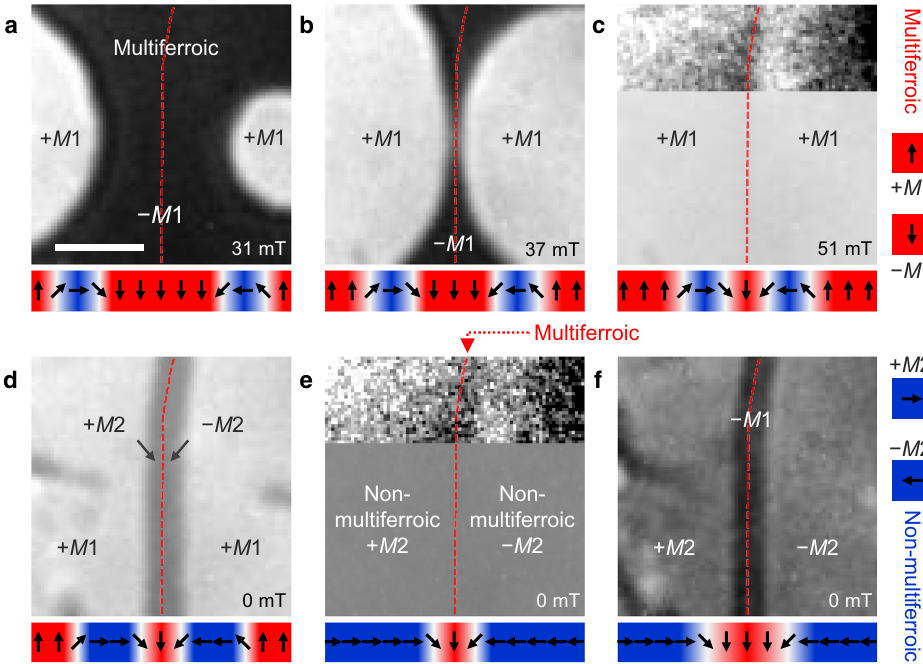
Fig. 2 Transformation of a multiferroic bulk domain into a multiferroic domain wall in a non-multiferroic environment. Panels a – f show the same area, using the same gray scale (except in the insets of c and e , which are rescaled to minimum = black, maximum = white). Arrows indicate the order- parameter orientation (see Fig. 1a) for the horizontal succession of phases in the associated images. a – c Starting from a single-domain state ( − M 1, dark), two opposite multiferroic domains ( + M 1, bright) are generated by application of an out-of-plane magnetic fi eld H . The + M 1 domains grow until they meet along the red dashed line. Here, the two domain walls in a and b have merged into a single topological object, which becomes visible in the inset. d , e Setting T = 1.8 K at H = 0 returns the sample to the non-multiferroic M 2 state. The wall separating the + M 1 domains in c expands into opposite M 2 domains (gray) separated by a multiferroic domain wall that becomes visible in the inset. f Heating the sample to 2.3 K lets the multiferroic domain wall in e expand into a multiferroic − M 1 bulk domain. Scale bar, 100 μ